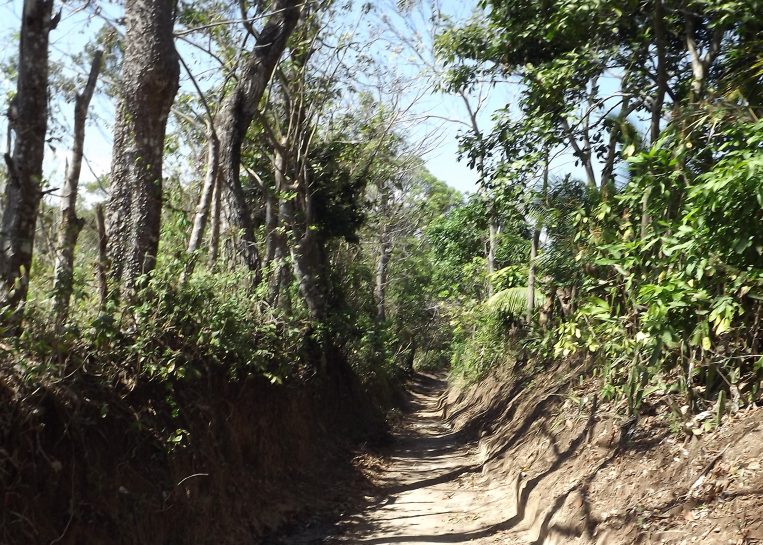
Sandinista
lanceolatum habitat, tropical dry forest and thorn, near Granada, Granada department, Nicaragua. Photo: Ray Gabriel.